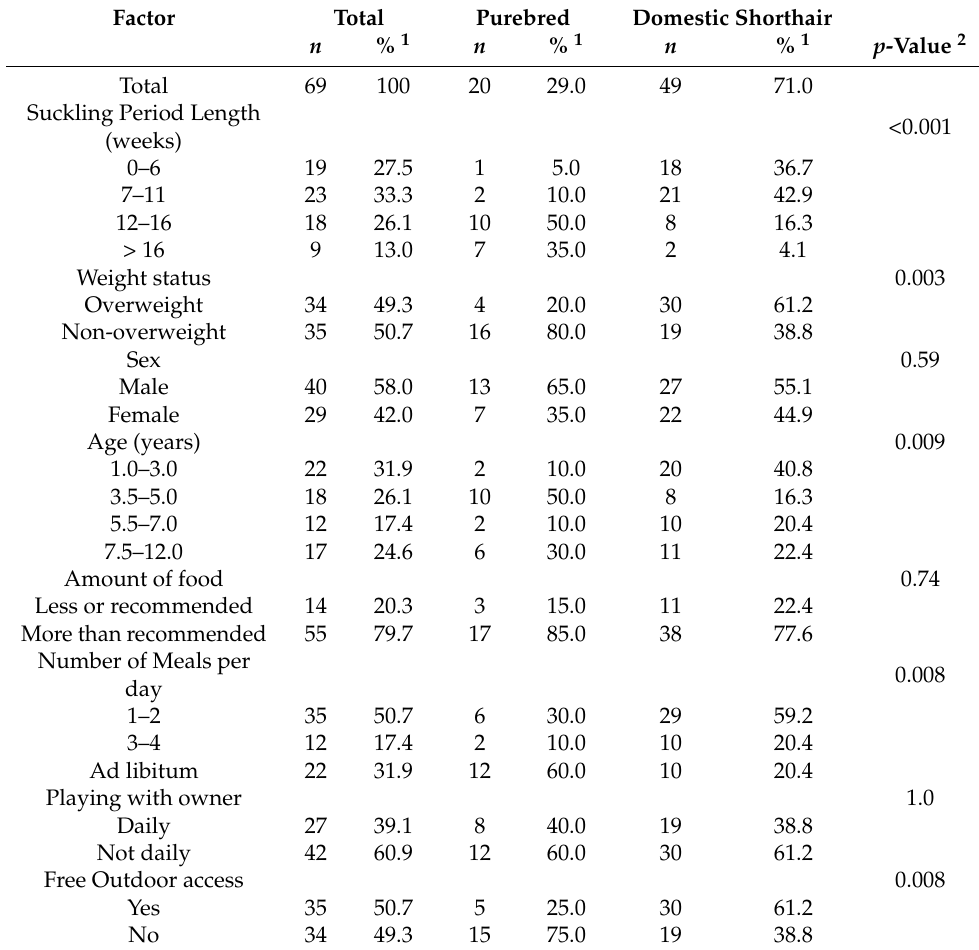
Table 4. Number (%) of purebred and domestic shorthair cats per suckling period group and demographic